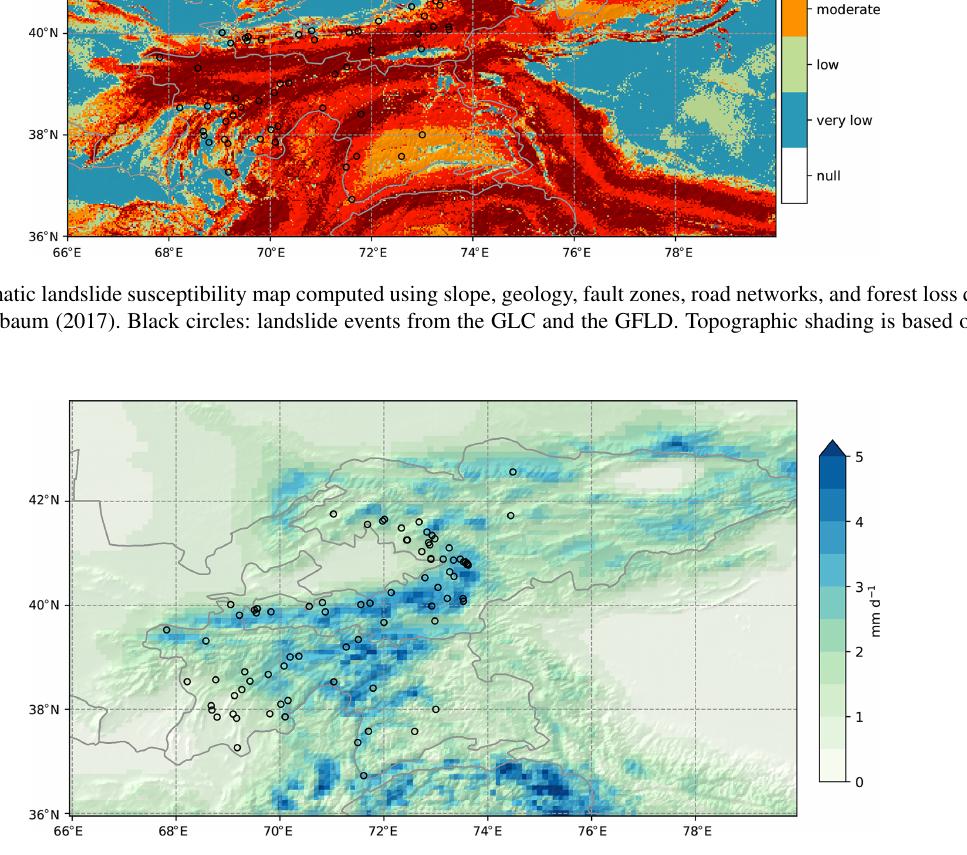
Figure 9. Annual sum of rainfall and snowmelt averaged over 2014–2018 from HAR v2. Black circles: landslide events from the GLC and the GFLD. Topographic shading is based on DEM data from